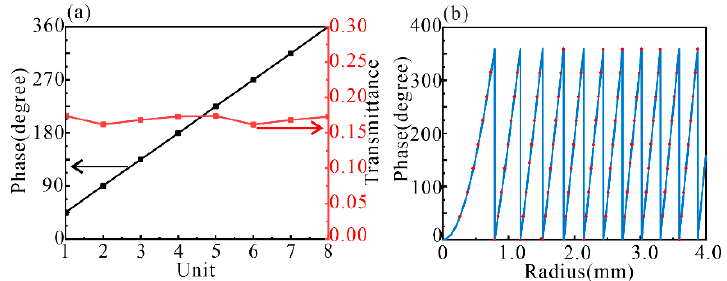
Figure 2. ( a ) Numerical results of transmittance and phase values of the eight resonant units in each super unit cell at 1.1 THz. The black curve shows the phase of cross-polarized scatter, and the red curve shows transmittance. ( b ) The solid curve shows the required phase, which is calculated from Equation (1) at 1.1 THz, and the red dot shows the phase that can be actually provided by resonance units.